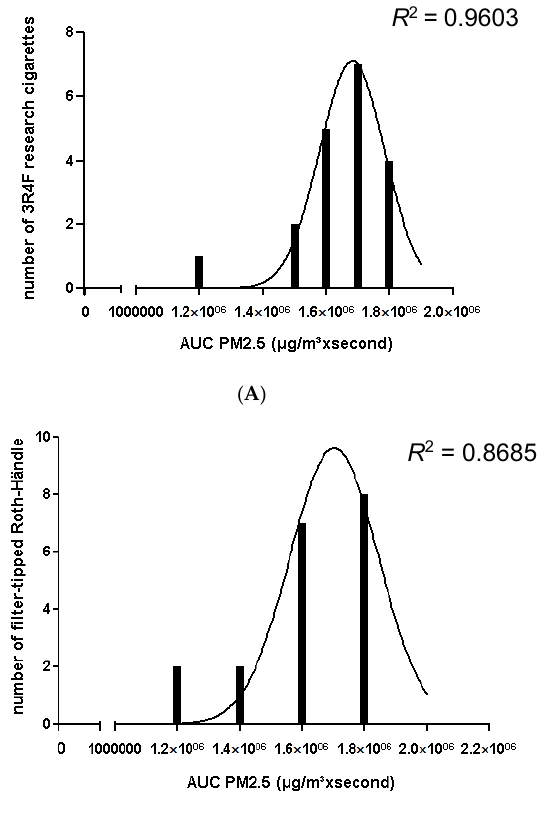
Figure 6. Comparison of the 3R4F, filter-tipped Roth-Händle and non-filter Roth-Händle. Significance was assumed when p < 0.05 (* means significant). ( A ) PM 2.5 mean concentrations and ( B ) PM 2.5 AUC are